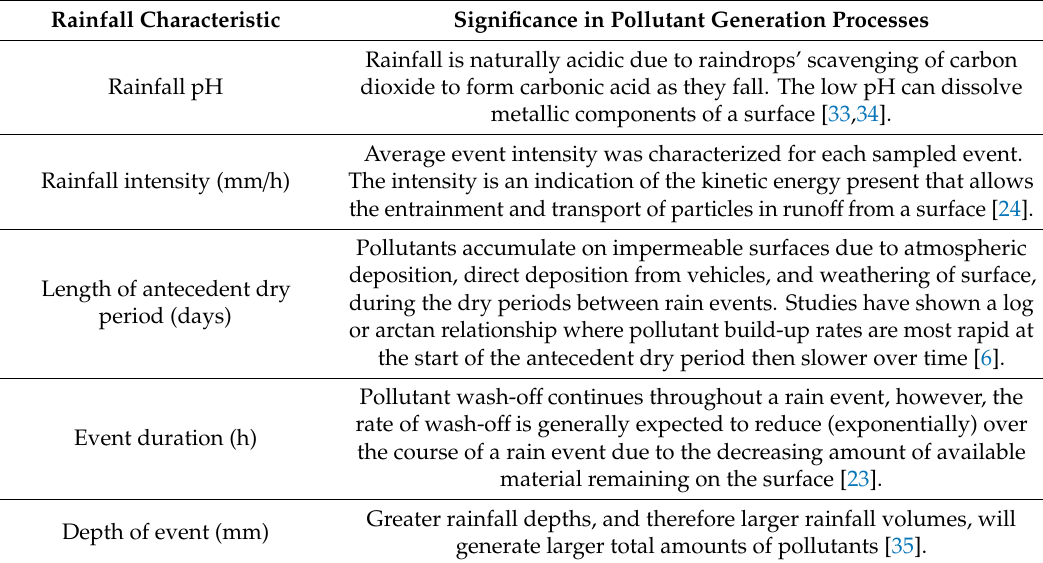
Figure 1. MEDUSA2.0 model framework. TSS, total suspended solids; TCu, total copper; DCu, dissolved copper; TZn, total zinc; DZn, dissolved zinc. Table 2. Rainfall characteristics used in the urban runoff pollutant load modelling.